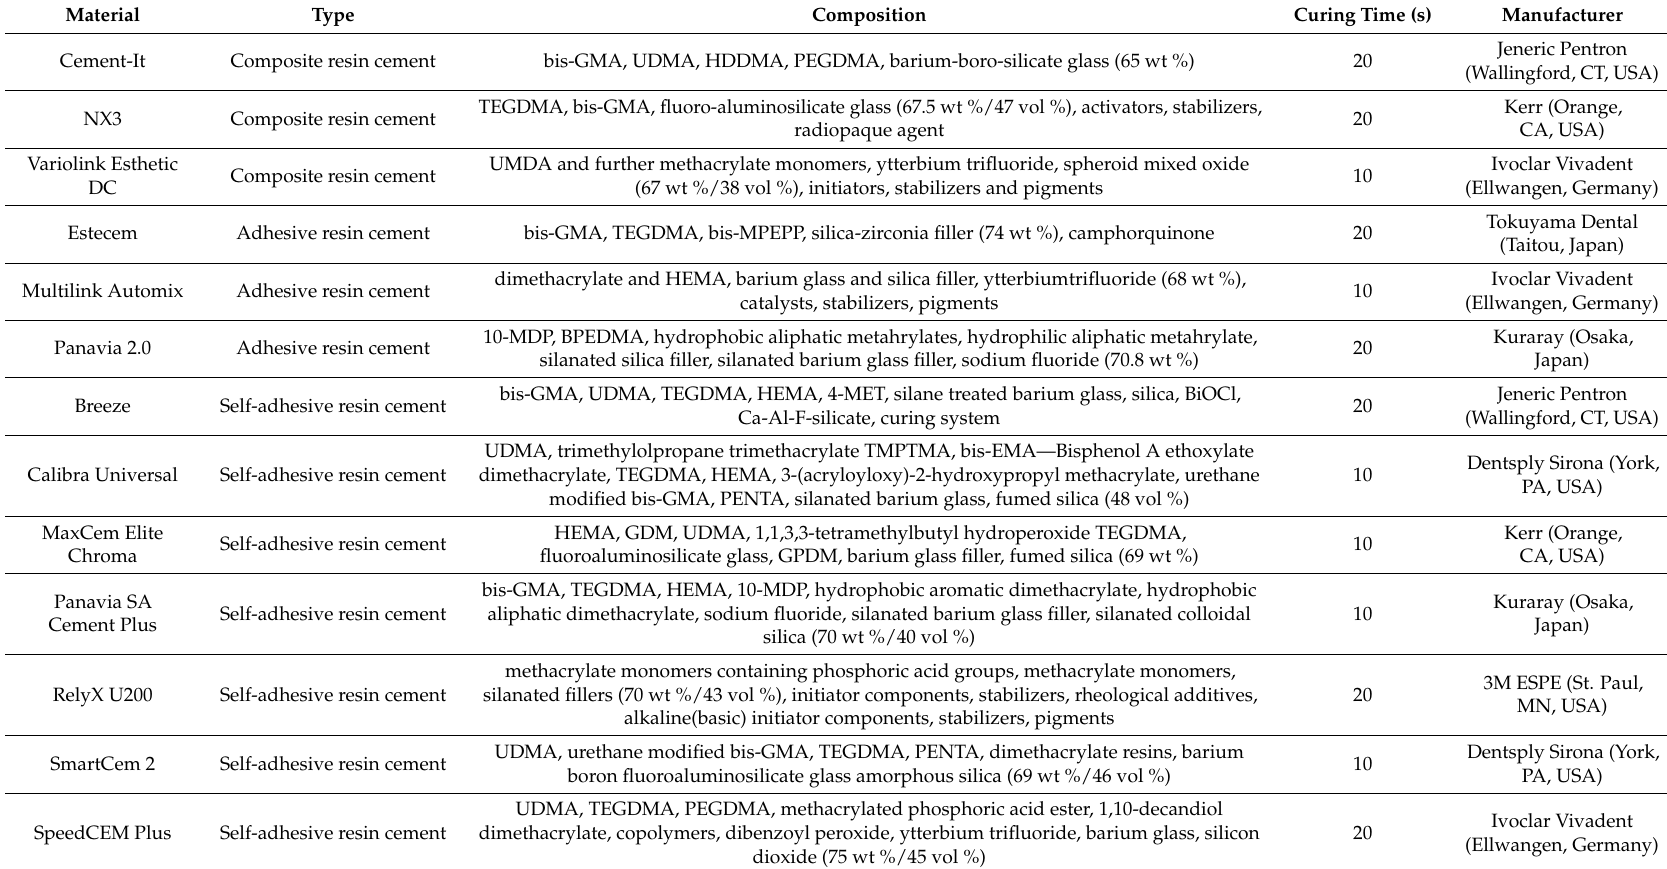
Table 1. The composition of resin